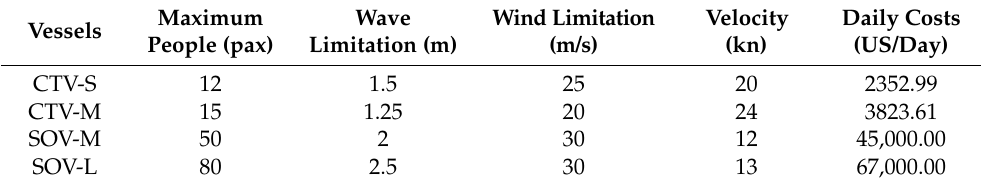
Table 2. Vessel’s characteristics and cost